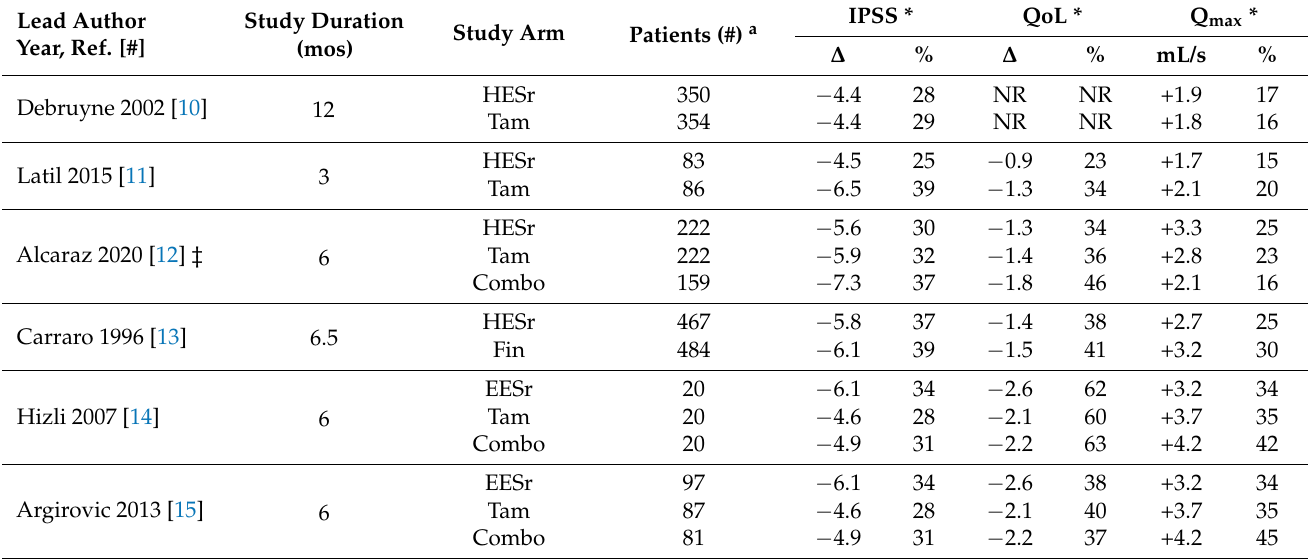
a Number of patients at study end. * Values rounded off to one decimal point. Percentages are rounded off to the nearest whole number. ‡ In Alcaraz 2020 the number of patients for Qmax were 43, 33 and 46 for HESr, tamsulosin and the combination, respectively. Data is per protocol (PP) obtained from supplementary material available at https://www.mdpi.com/2077-0383/9/9/2909/s1, accessed on 30 July 2021). ∆ , mean change; − , negative change; #, number; %, percent change; +, positive change; AUA, American Urological Association; IPSS, International Prostate Symptom Score; EESr, ethanolic extract of Serenoa repens ; Fin, finasteride; HESr, hexanic extract of Serenoa repens; LUTS, lower urinary tract symptoms; mL/s, milliliters per second; NR, not reported; mos, months; QoL, quality of life; Qmax, peak urinary flow (mL/s); Ref., reference citation; Tam,